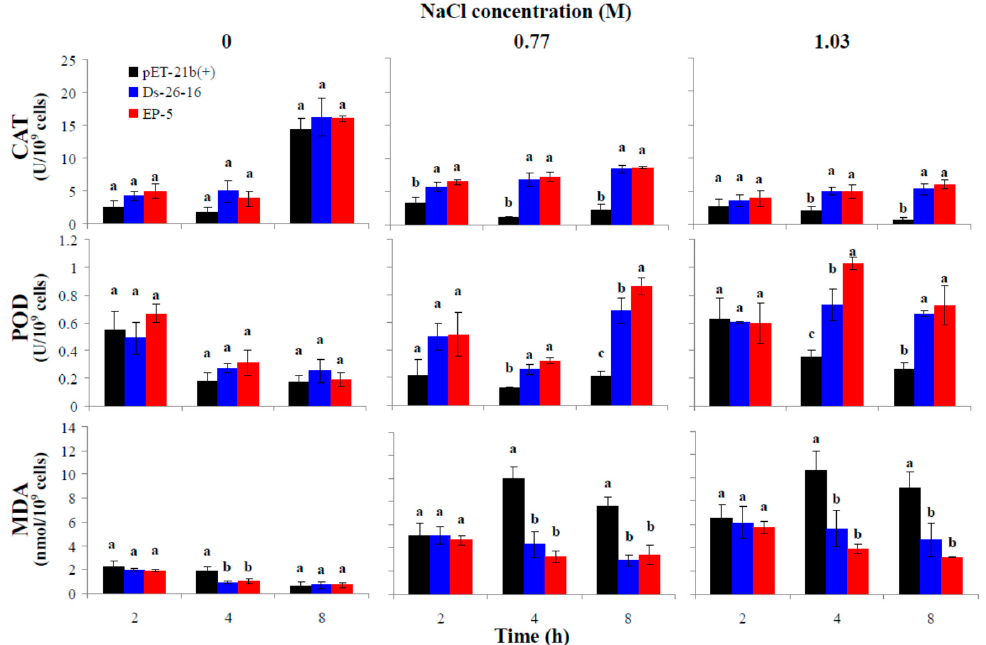
Figure 4. Antioxidant ability of E . coli transformants expressing Ds-26-16 or EP-5 under different NaCl stress levels. Catalase (CAT) and peroxidase (POD) activities and malondialdehyde (MDA) content were determined after pET-21b(+), Ds-26-16 and EP-5 cultured under NaCl stress at different times. a, b or c stands for the significant differences ( p < 0.05) between the strains under the same salt concentration at the same growth time.